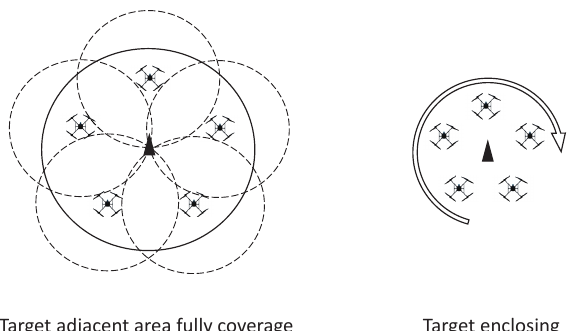
Figure 1. Depiction of the target-enclosing and covering